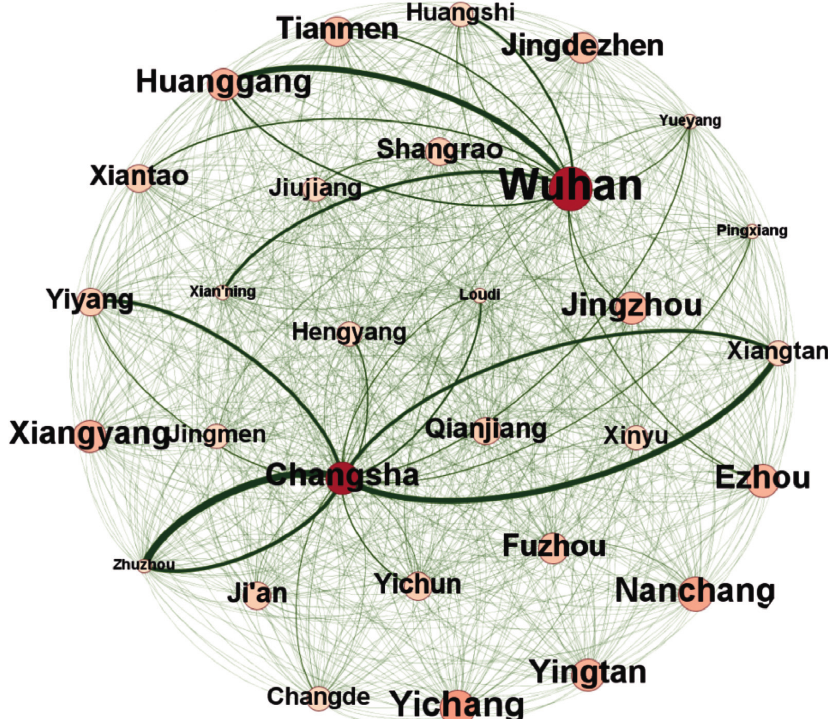
Figure 4: The force-directed layout of CO 2 emission network. Note: the force uses the Fruchterman–Reingold